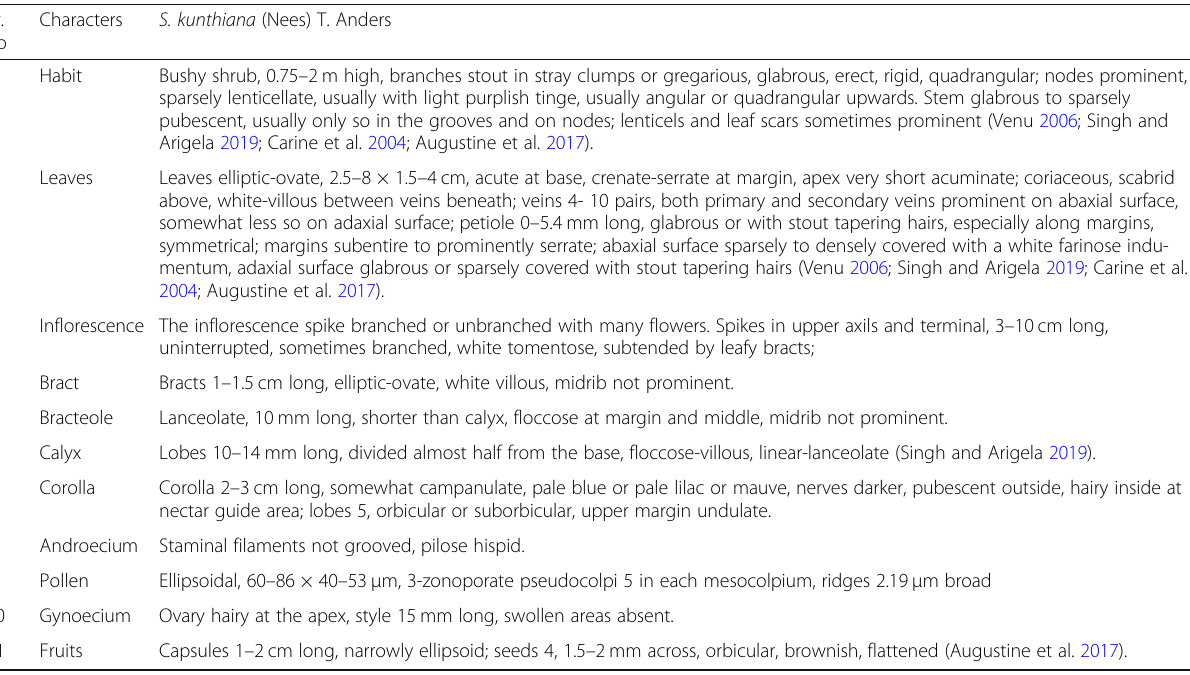
Table 1 Morphological characteristics of S. kunthiana (Nees) T.